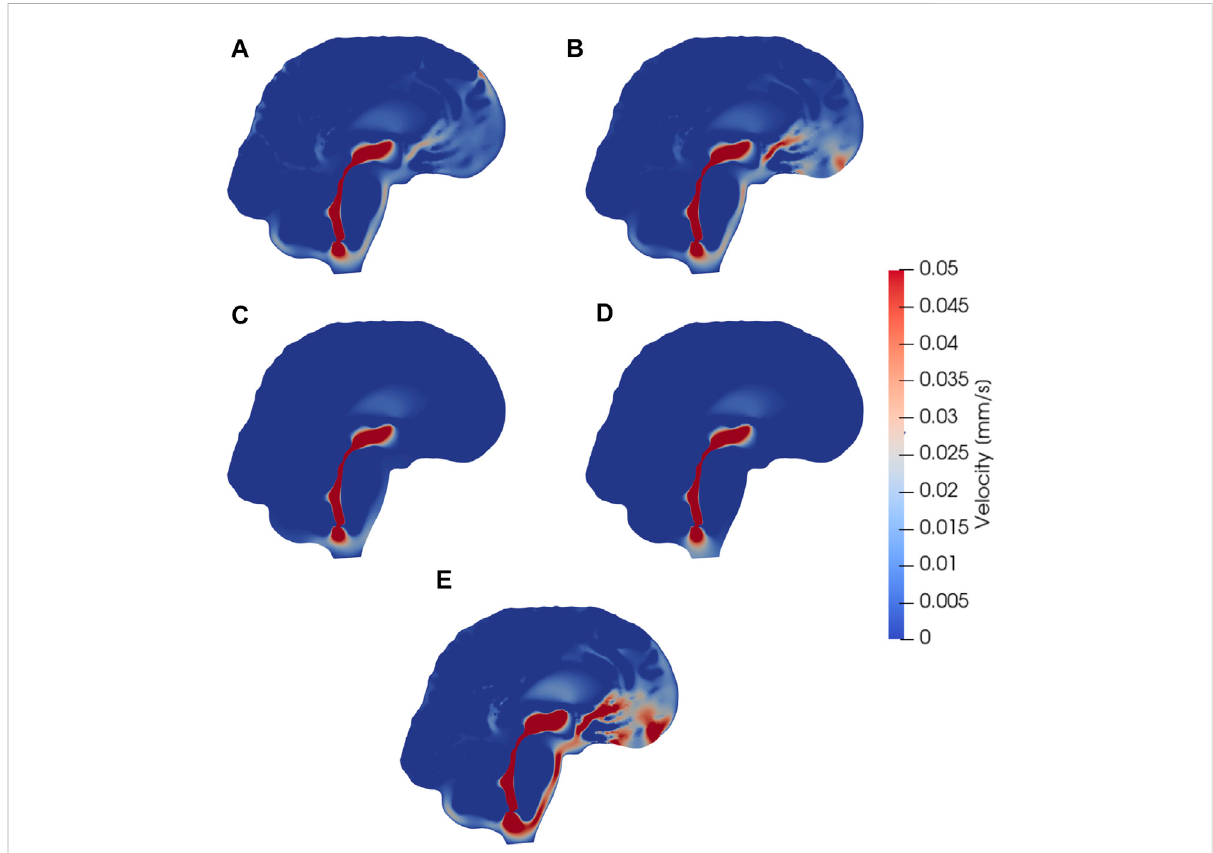
FIGURE 3 Sagittal views (cut through the center of the aqueduct) of CSF velocity magnitudes induced by steady CSF production in the choroid plexus combinedwithdifferentCSFef fl uxpathwaymodels,orareversed fl owscenario.Sub fi guresshowvelocity fi eldsresultingfromCSFef fl uxthrough (A) the parasagittal dura (B) the cribriform plate (C) the meningeal lymphatics (D) production in the foramen magnum and absorption in the choroid plexus, (E) the cribriform plate with double production. The color map is capped at 0.05 mm/s for visualization